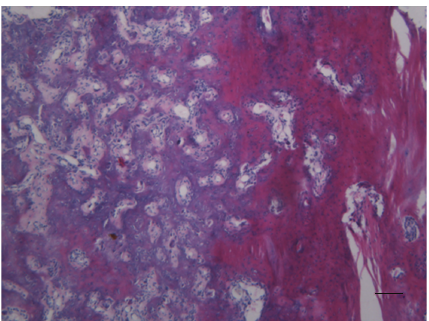
Figure 4: Histologically, a nidus of osteoid osteoma (left side) is seen bordered by sclerotic bone (right side). Bar: 100 µ m.